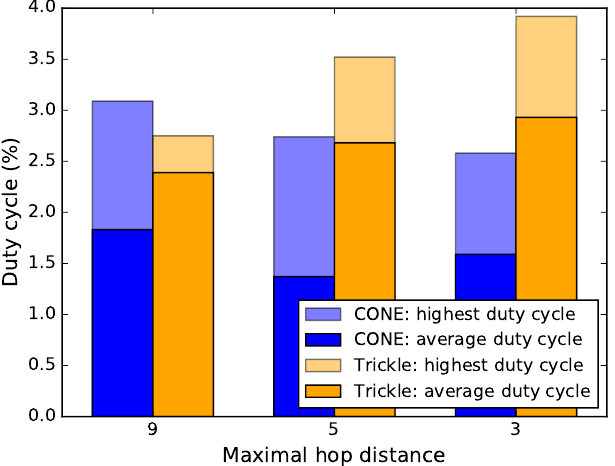
Figure 13. Comparison of average (radio) duty cycles in simulations.